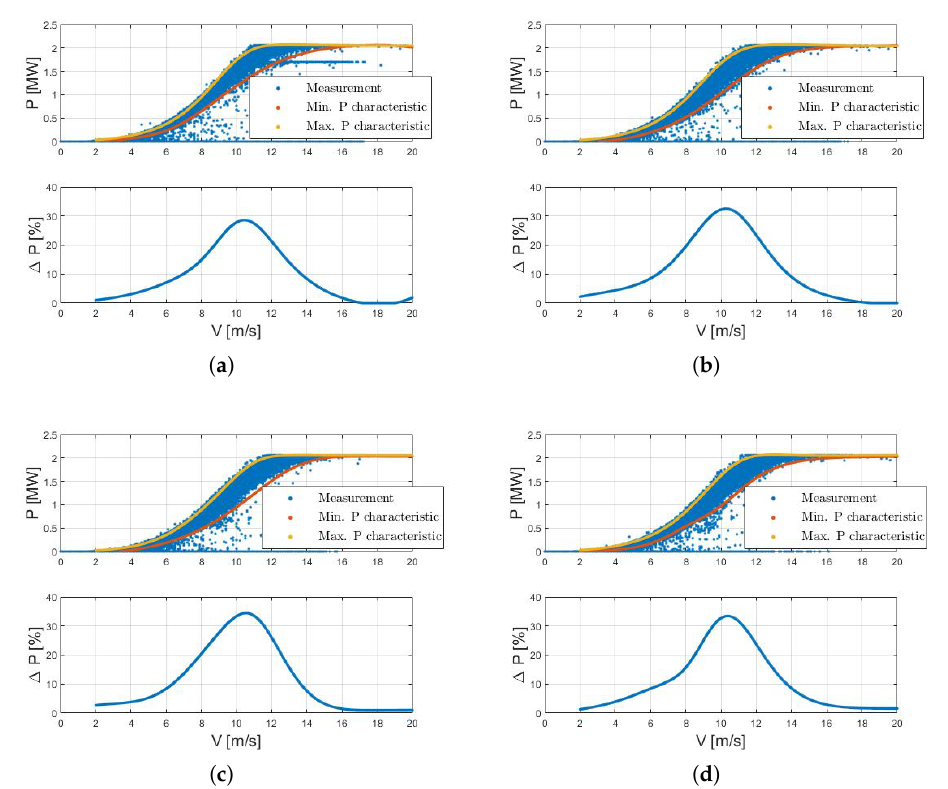
Figure 6. As-measured data (in blue) and approximate minimum/maximum power characteristic envelope (red/yellow), for selected E1, E2, E5, and E15 turbines of wind power plant FW3. ( a ) Turbine E1. ( b ) Turbine E2. ( c ) Turbine E5. ( d ) Turbine